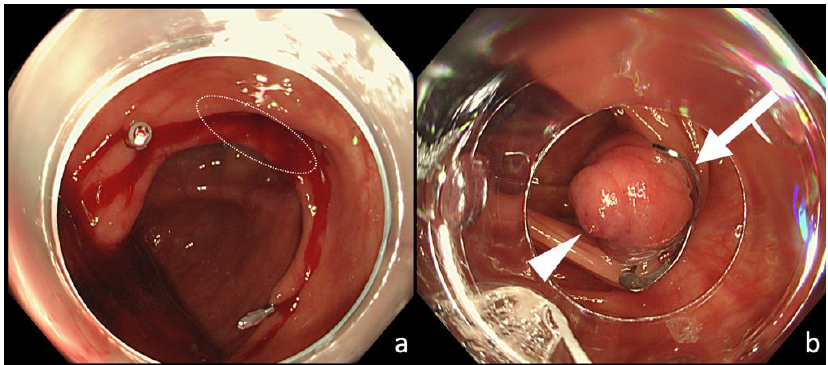
Figure 2. Hemostatic treatment using the OTSC method for colonic diverticular bleeding. ( a ) Place two clips near the bleeding diverticulum (white circle) for marking. ( b ) An OTSC (white arrow) released to the responsible diverticulum. The diverticulum is inverted and bulged by OTSC and then fixed. Hemostasis is achieved, and an exposed blood vessel (white arrowhead) is identified at the center mound.